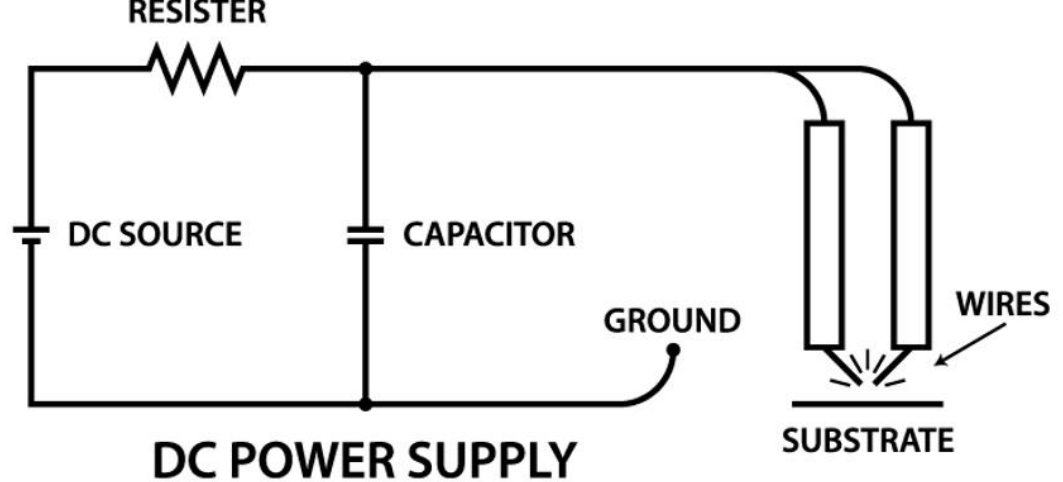
Figure 1. Conceptual representation of sparking machine apparatus. For pictures of the machine please see the Supplementary information.